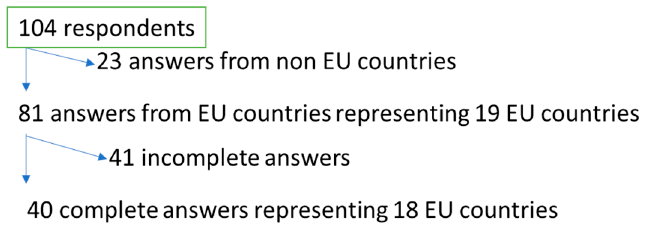
Figure 1. Flowchart of the SN organizations’ answers .